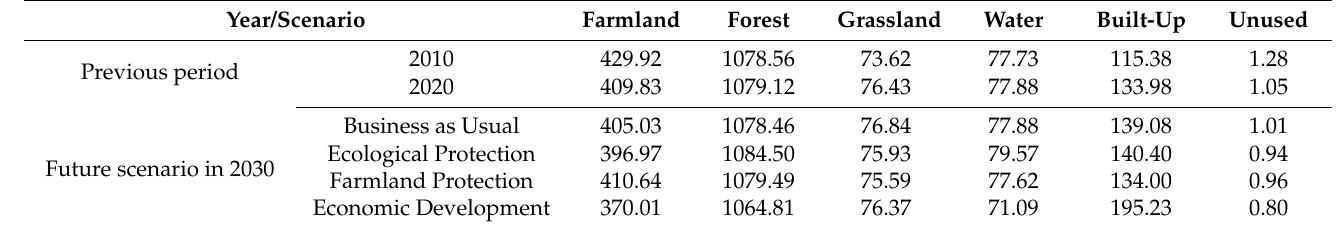
Table 2. Land use area in 2010, 2020, and 2030 under multi-scenario (Business as Usual, Economic Development, Ecological Protection, and Farmland Protection, unit: 10 4 ha). Year/Scenario Farmland Forest Grassland Water Built-Up